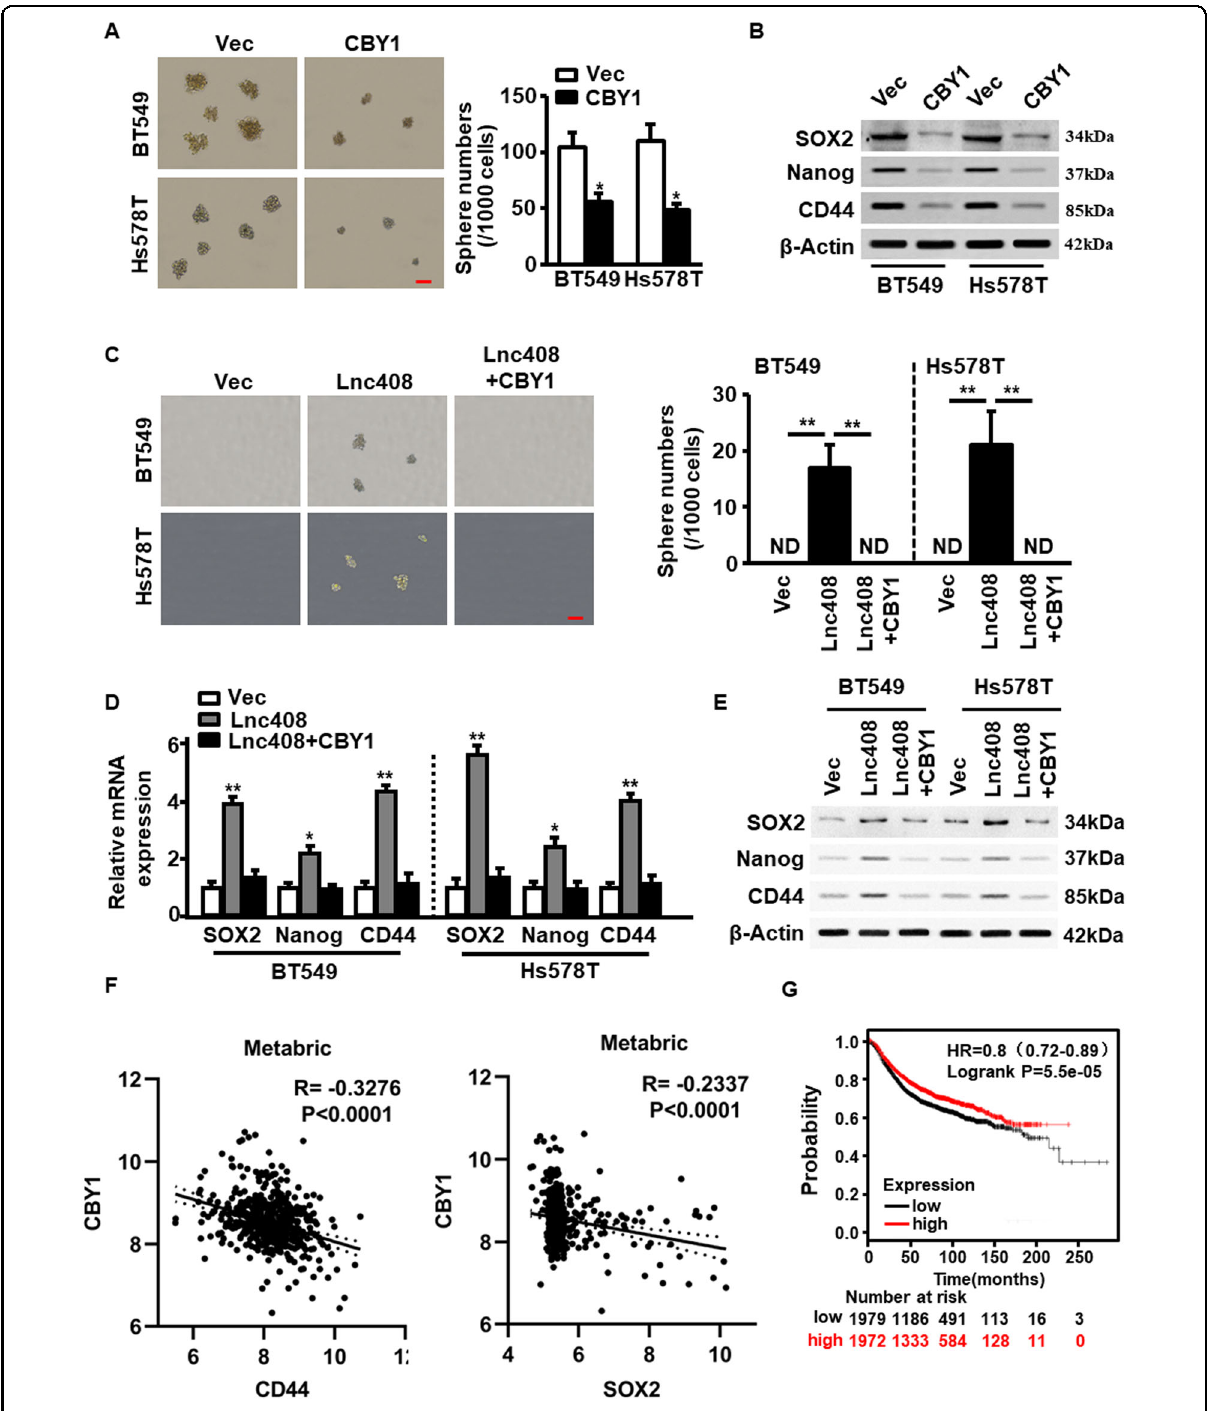
Fig. 5 Lnc408 suppresses the expression of CBY1 to regulate BCSC self-renewal and stemness maintenance. A Ectopic CBY1 was transfected into BC cells to check the mammosphere-forming capacity of CSCs, and representative pictures of mammospheres are shown. The right panel represents the statistical results of mammosphere numbers as means ± SD (* P < 0.05; scale bar, 100 μ m). B Breast cancer stemness markers (SOX2, Nanog, and CD44 were assessed in CBY1-overexpressed BCSCs by western blotting. C The non-CSC-like BC cells were transfected with control vector, lnc408 or lnc408 combined with CBY1, the mammosphere formation capacities were assessed in serum-free suspended culture. The right panel represents the statistical results of mammosphere numbers as means ± SD (** P < 0.01; ND none detected; scale bar, 100 μ m). D , E The mRNA and protein levels of CSC markers (SOX2, Nanog, and CD44) were determined by qRT-PCR ( D ) and western blotting ( E ), respectively (* P < 0.05, ** P < 0.01). F Pearson correlation analysis of CBY1 and CD44, CBY1 and SOX2 in 474 breast cancer tissues based on Metabric database. G Kaplan – Meier survival analysis to show the BC patients with low CBY1 expression ( N = 3851) had poor prognosis, using TCGA